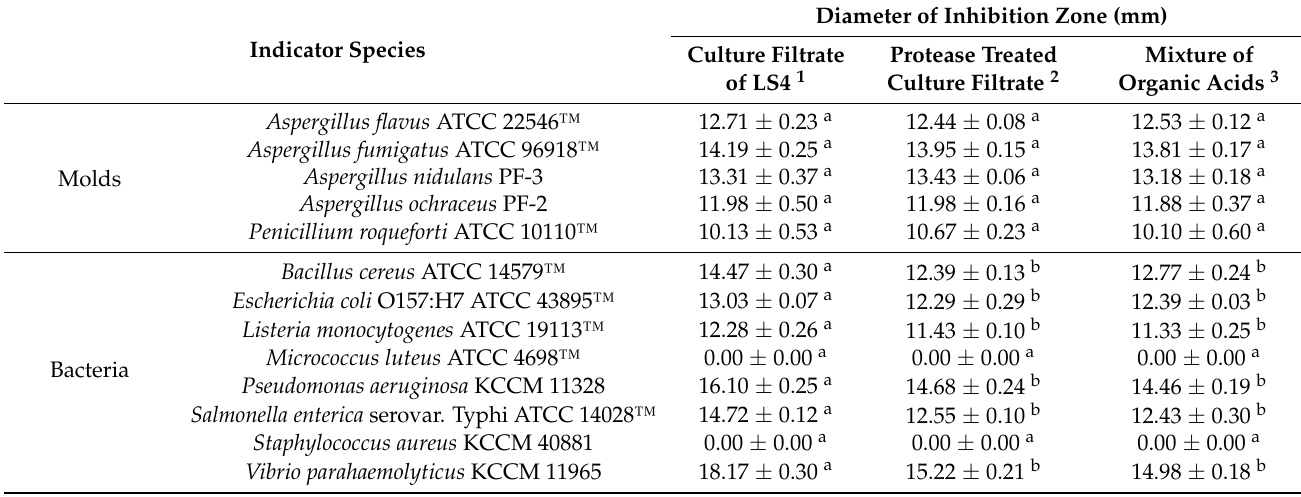
Culture filtrate 1 of L. aenigmaticum LS4, the culture filtrate treated with protease (2 mg/mL), 2 and the organic acid mixture 3 in the culture filtrate quantified by IC analysis were used as antimicrobial samples, as described in Materials and Methods. Means with different letters indicate significant differences ( p < 0.05) between antimicrobial